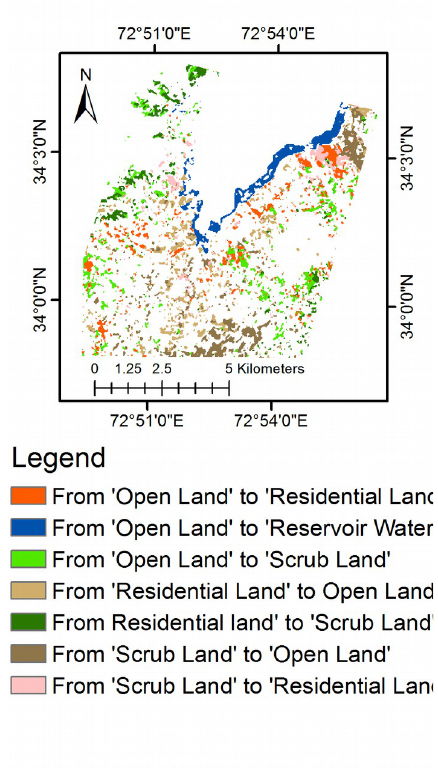
Figure 3. Winter to summer seasonal change detection 3.5 Seasonal Change Detection from Winter to Autumn Change detection matrix (Table 4) from winter to autumn shows decrease of spatial mapping of forest 91.5%, residential land 19.8%, scrub land 17.1% and increase of open land 15.1%, reservoir water 182.7% waterway 5.9 %. Figure 4 shows category changes scrub land to open land and residential land to open land with increase in open land. Similarly, small category changes from open land to scrub land, scrub land to open land and open land to residential land resulted due to seasonal change. Change detection from winter to summer resulted increase in increase in open land mapping.